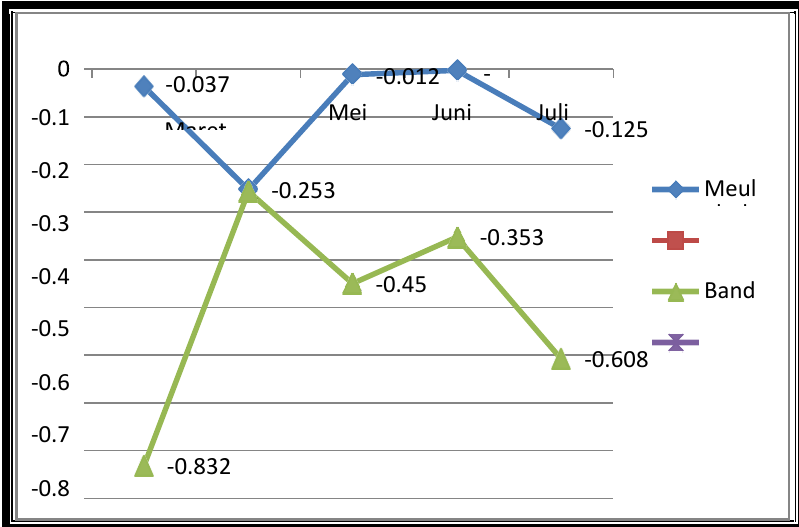
Figure 1 Change Requests Rice Price elasticity between March and July